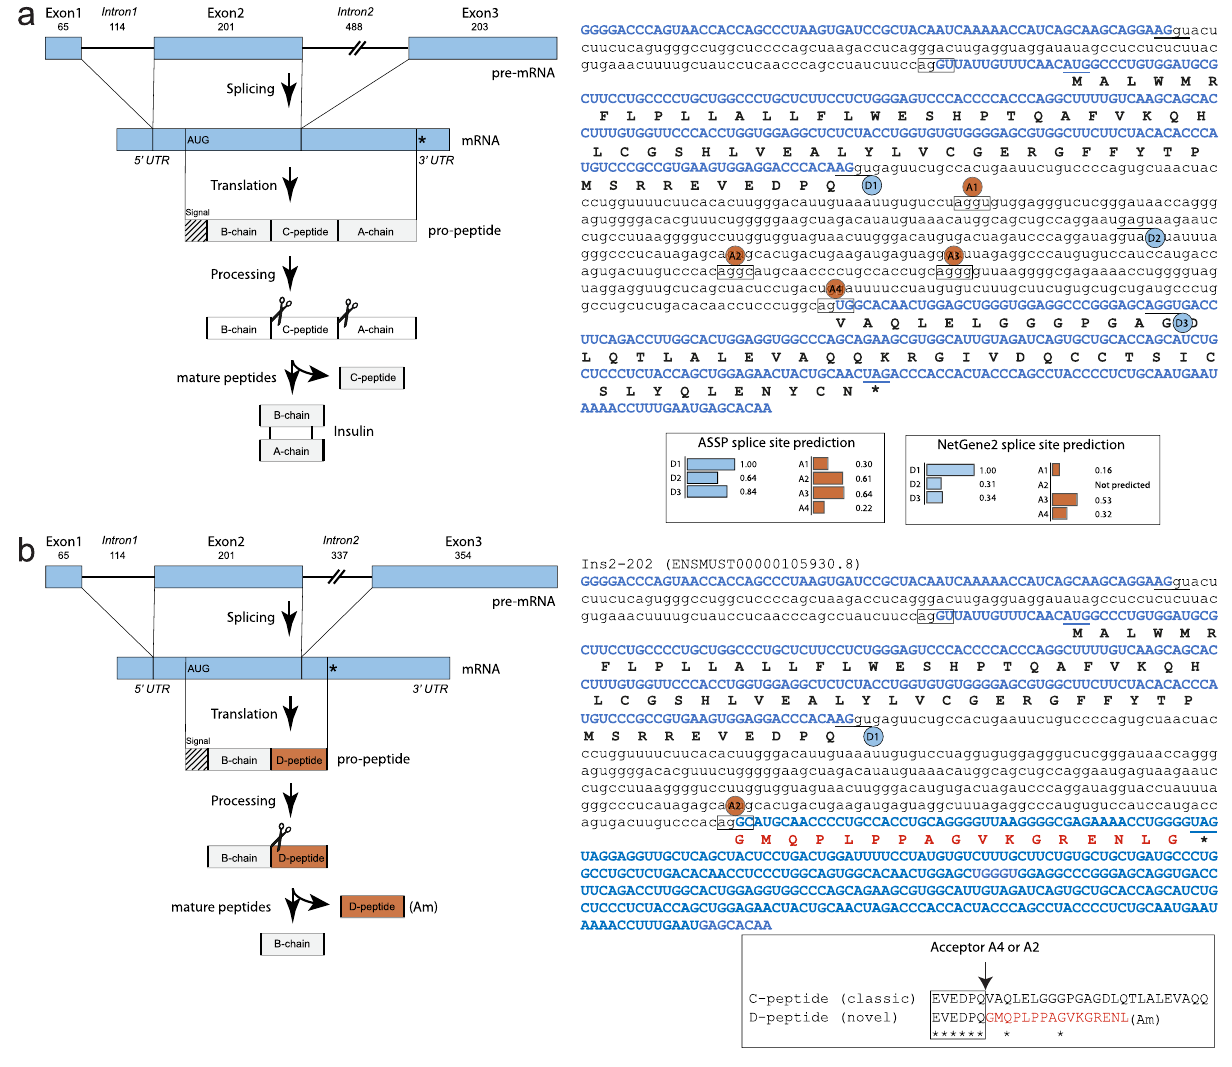
Fig. 6 | A unique high-scoring peptide formed through alternative splicing in insulin. a Insulin-2 (Uniprot: P01326; NCBI sequence: NC_000073.7: c142233463- 142232393) from Mus musculus strain C57BL/6J. Splicing and pro-peptide proces- singwillgeneratethematureinsulin ’ sA-andB-chainandtheconnecting-peptide(C- peptide).Thesplicinginintron2takesplacebetweendonorsite1(D1)andacceptor site 4 (A4) as shown on the right. Introns are in small letters, exons is in capital letters.TheASSPandNetGene2splicesitepredictionsshowtherelativestrengthof donor sites (underlined; blue) and acceptor sites (boxed; red) normalized to D1.